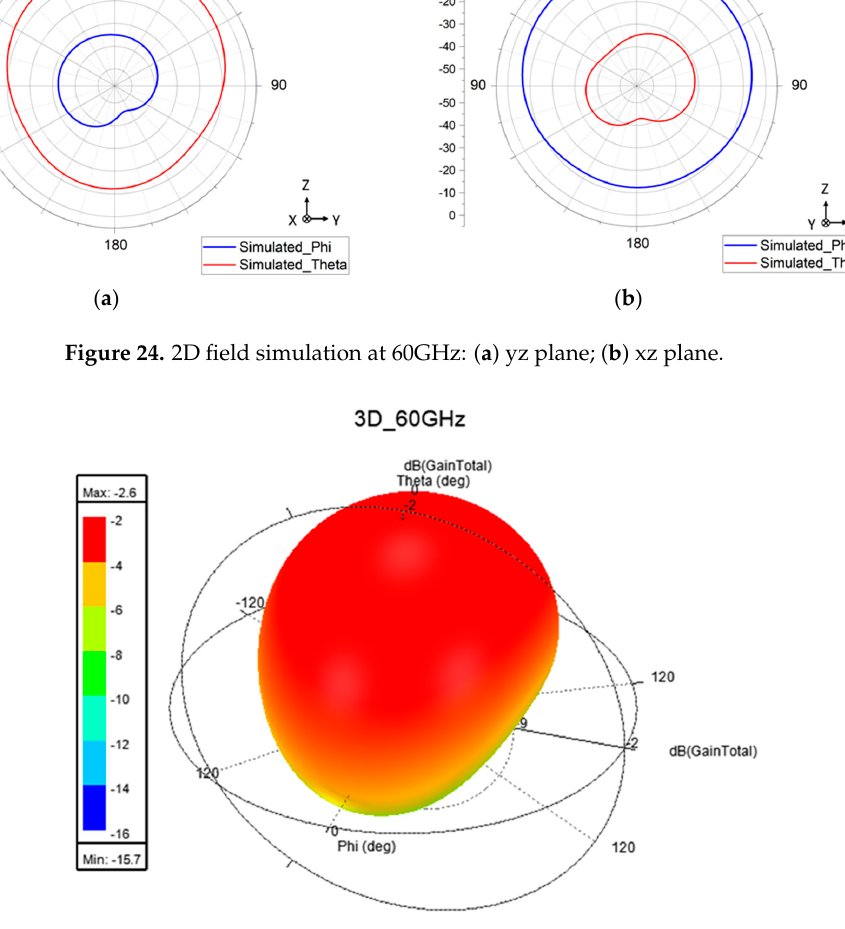
Figure 25. The 3D field simulation diagram at 60 GHz.